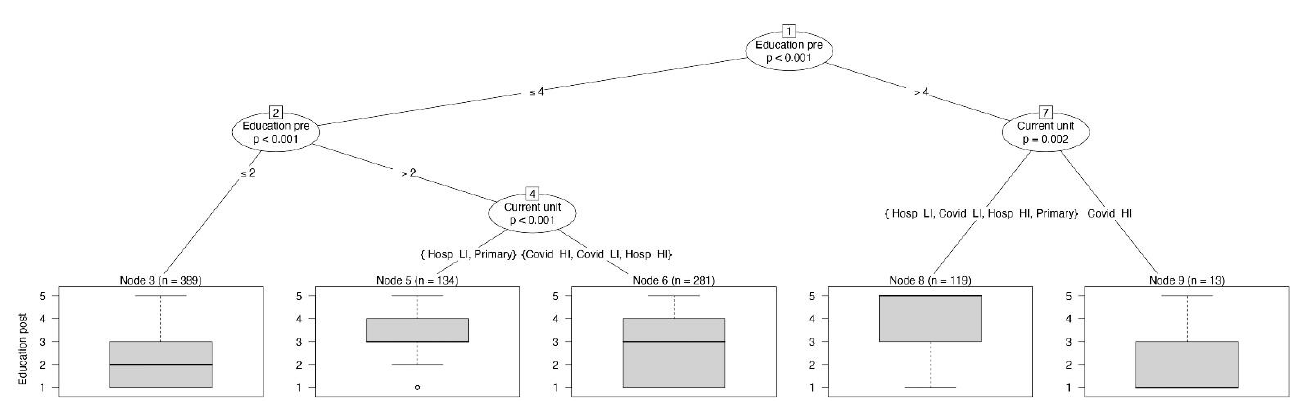
Figure 2. The conditional inference tree with the frequency of nursing techniques as dependent variable, reported at the bottom of the figure as boxplot.